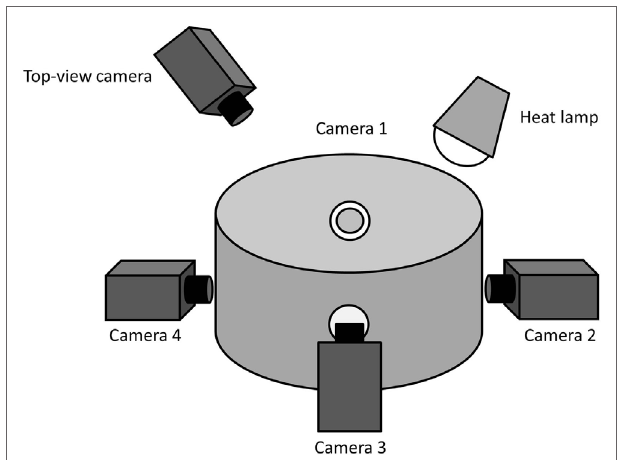
FigUre 1 | Outline of the observation arena . This indicates the position of the four cameras placed at equal distance to each other to record facial expressions of the piglets. The camera placed above the observation arena recorded the general activity of the